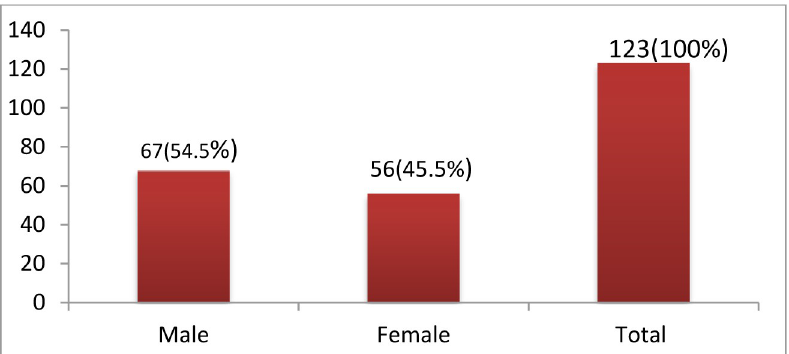
Fig 1. Sex distribution of risky sexual practice among big construction site daily laborers in Bahir Dar in city.